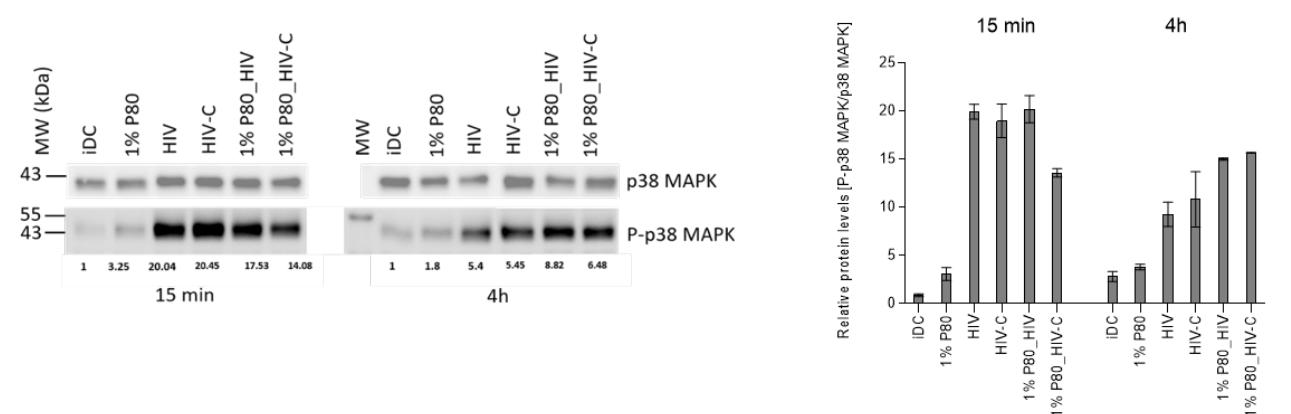
Figure 5. P80 natural essence activates sustained p38 MAPK phosphorylation in HIV- and HIV-C-exposed DCs. ( Left ) HIV- and HIV-C-loaded DCs illustrate pre-treated with 1% P80 natural essence illustrate increased p38 MAPK phosphorylation compared to their infected counterparts (HIV vs. HIV-C) after 4 h. iDCs and DCs treated with 1% P80 only were used as negative controls, p38 MAPK phosphorylation (P-p38 MAPK) was normalized to the loading control (p38 MAPK) and iDCs at the respective time point (15 min, left; 4 h right). x-fold increase in the P-p38 MAPK signal is illustrated below the IB. ( Right ) A summary of p38 MAPK phosphorylation at 15 min and 4 h of three independent experiments is illus- trated.